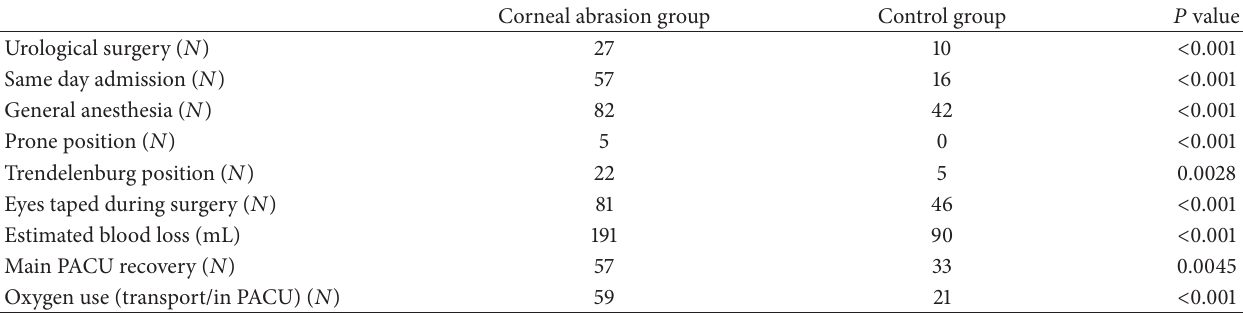
Table 2: Statistically significant risk factors.